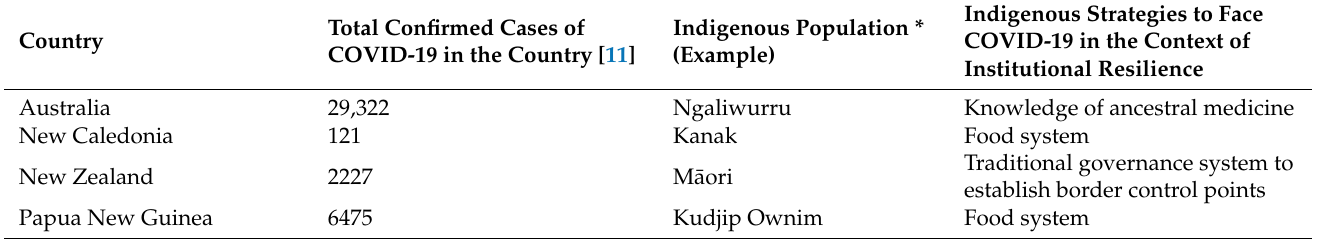
Table 6. Oceania countries with indigenous populations and their strategies deployed in the face of COVID-19. Total Confirmed Cases of Country COVID-19 in the Country [11]